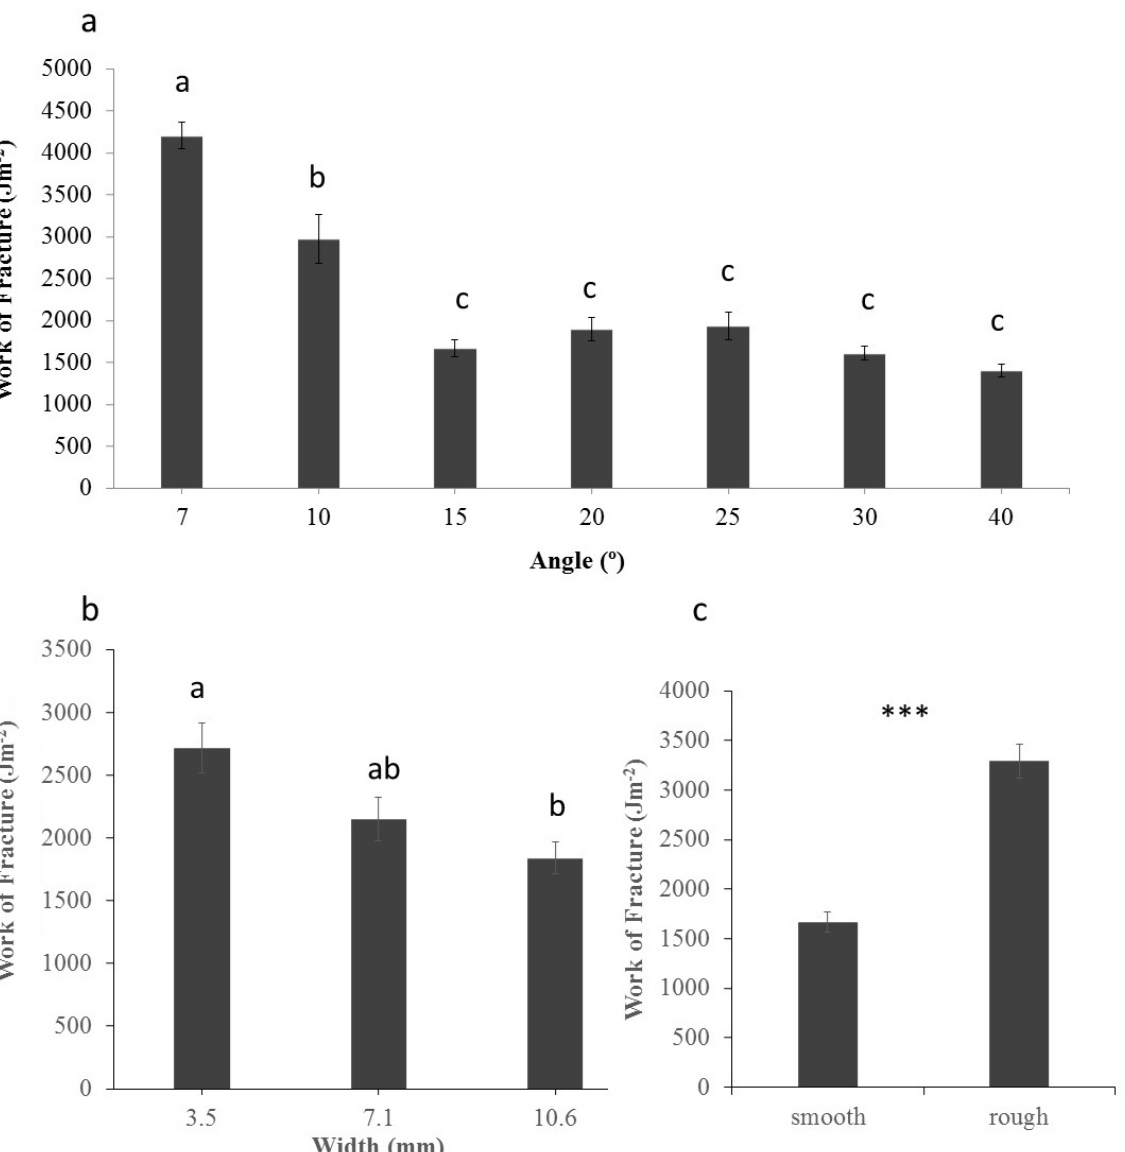
Figure 6. a) The results of the wedge splitting tests. Graphs show the mean work required to create a given fracture surface for wedges with a) different angle b) different width and c) different roughness. For a) and b) bars with a different letter are significantly different from each other. For c), *** denotes a highly significant difference (P < 0.001). Note that wedges with higher angle, broader blades and smoother surfaces needed less energy to cut through the coppice